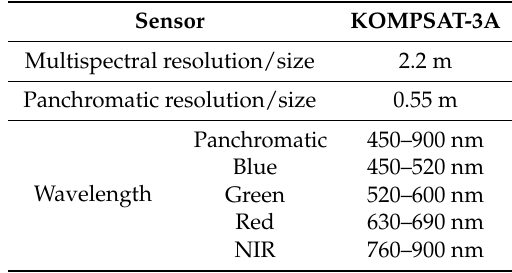
Table 1. The specifications of the Korea multipurpose satellite (KOMPSAT)-3A satellite